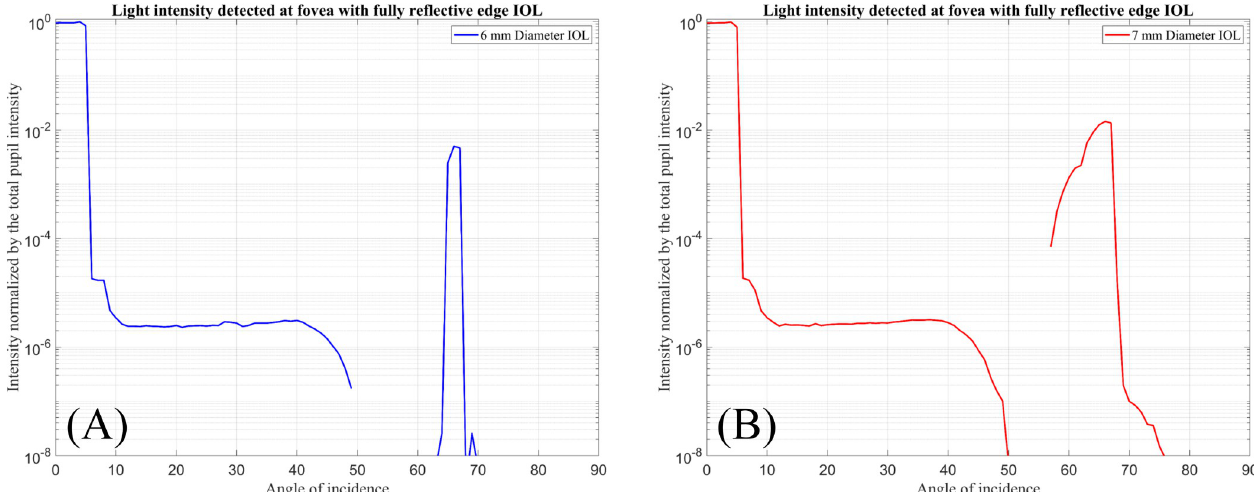
Fig 5. Normalised input intensity detected by Detector-F over the incident ray angle. (A) For 6 mm diameter IOL with fully reflective edge surface. (B) For 7 mm diameter IOL with fully reflective edge surface.